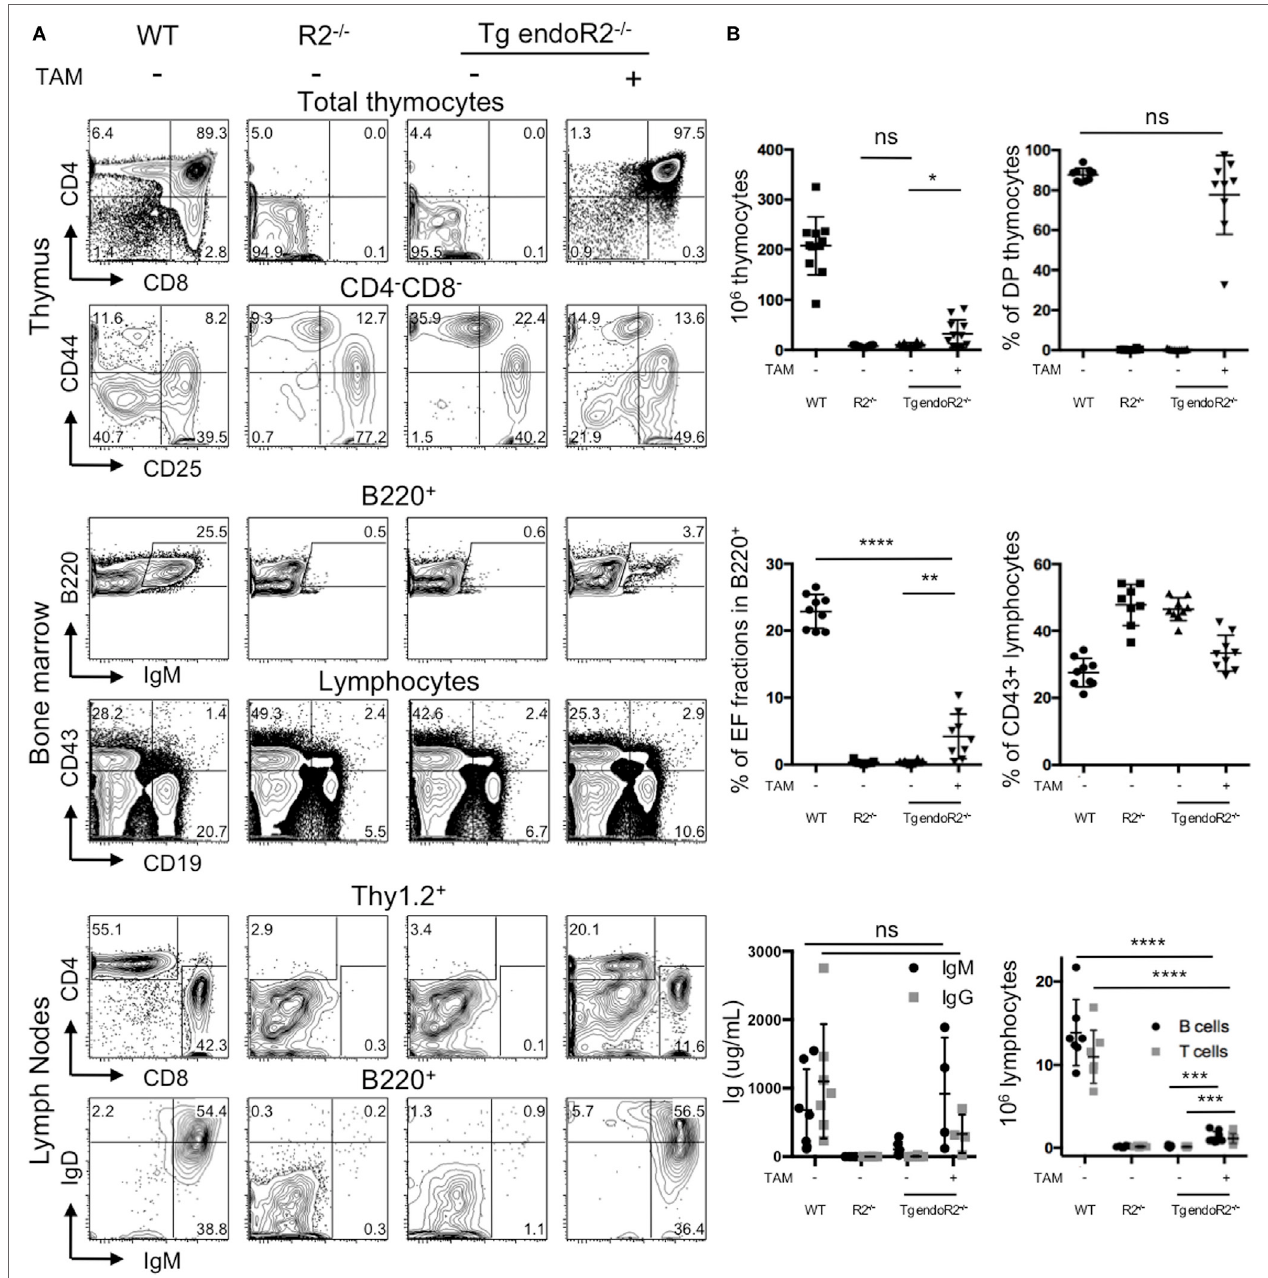
FigUre 2 | 4-Hydroxytamoxifen (TAM) induction of Tg endoR2 − / − partially restores lymphocyte development. Young adult Tg-endoR2 − / − mice (Tg endoR2 − / − ) were fed with normal ( − ) or TAM ( + ) food during 4 weeks before analysis. Untreated wild-type (WT) and recombination activating gene 2 (RAG2)-deficient (R2 − / − ) mice served as control. (a) Representative FACS profiles of thymocytes, bone marrow, and lymph nodes cells. (B) Full analysis of thymocytes numbers and frequency of thymic DP (upper panels); frequency of E and F fractions and CD43 + B cells in the bone marrow (middle panels); concentration of seric Ig and lymphocyte numbers in lymph nodes (bottom panels). *, **, and *** stand for p -values < 10 − 2 , 10 − 3 , and 10 − 5 , respectively. Results are representative of six independent